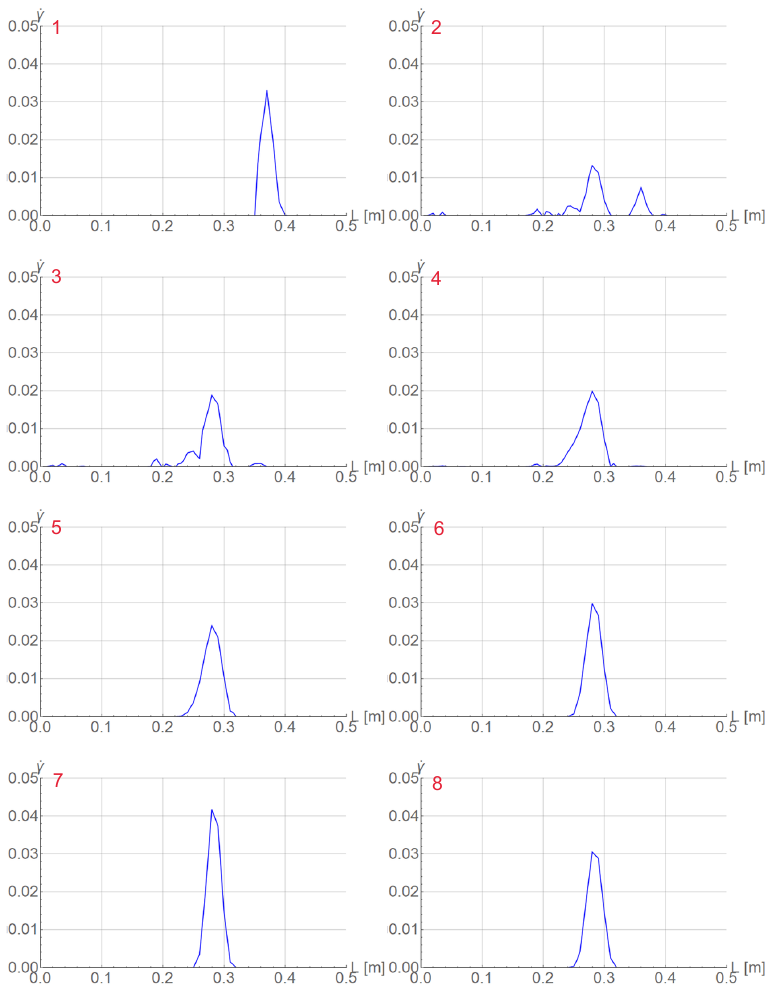
Figure 4. Distributions of ˙ γ at numbered states of selected serration for tensile rod